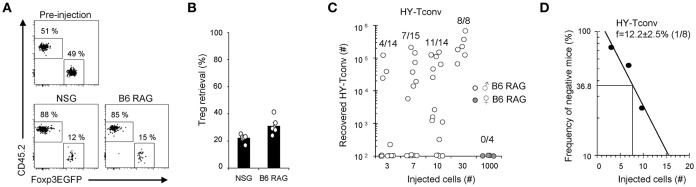
Adoptive transfer survival of Tconv and Tregs in lymphopenic hosts. (A,B) 5 × 104 Tregs (CD45.1) were mixed with 5 × 104 Tconv (CD45.2) and transferred into male NSG or B6-RAG mice. One day later, mice were sacrificed and their splenocytes analyzed by FACS using PE anti-CD4, APC anti-TCRβ, e450 anti-CD45.1 and AF700 anti-CD45.2 mAb. (A) Representative dot plots gated on live donor CD4+ TCRβ+ cells. (B) Histogram shows Tregs retrieval as a percentage of Tconv. Mean ± standard error of the mean (SEM) is shown. (C,D) Indicated numbers (3–1000) of CD4+ RAG2−/− Marilyn T cells were transferred into male or female B6-RAG mice. At day 7, mice were sacrificed and their splenocytes analyzed by FACS using APC anti-TCRβ and PE anti-CD4 mAb. (C) Absolute numbers of recovered live CD4+TCRβ+ Marylin T cells in individual mice are shown. (D) Numbers of injected Marilyn T cells are plotted against the log frequency of negative mice. Data are pooled from 2 (A,B) or 4 (C,D) independent experiments.